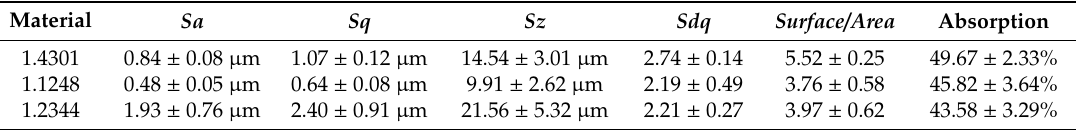
Table 2. Mean values of initial state specimens.